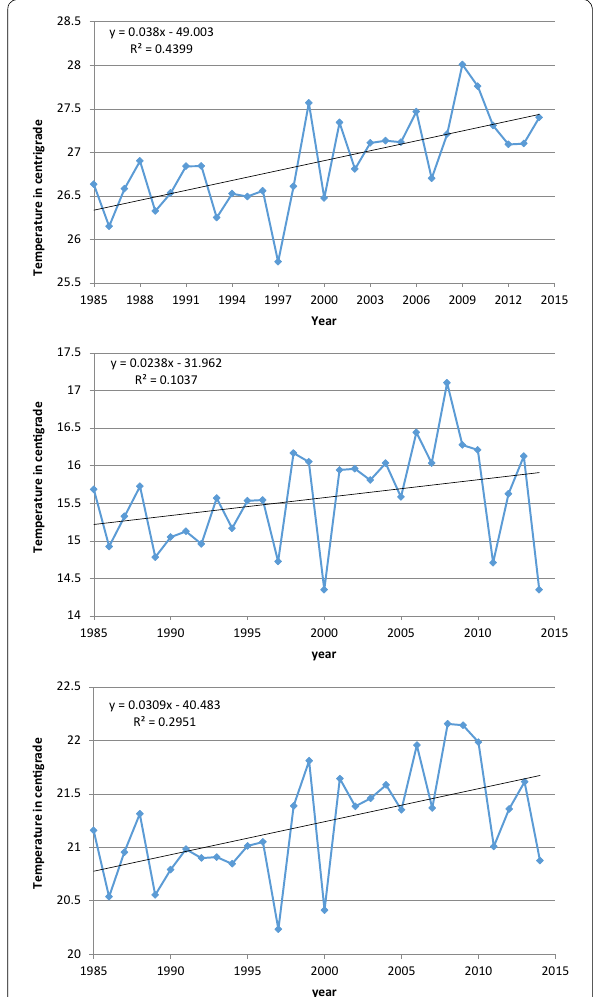
Fig. 14 30 years’ maximum, minimum and mean temperature trend for Pokhara